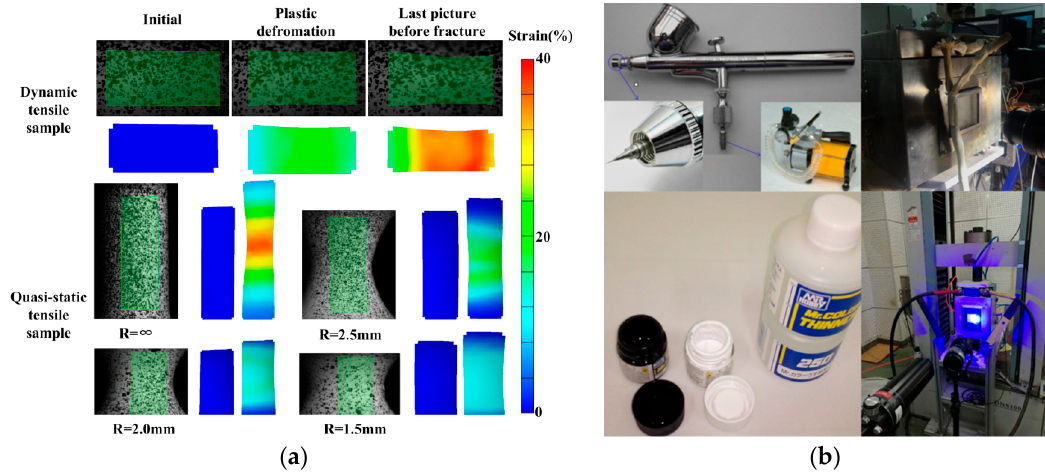
Figure 4. ( a ) Strain fields calculated by using the DIC method and micro speckles; and ( b ) heating furnace with high-temperature resistant glass, an airbrushing tool and an enamel paint.